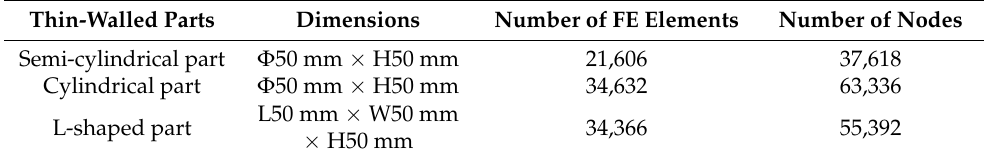
Figure 9. 3D FE mesh models of thin-walled structures. Table 3. Dimensions of the proposed thin-walled structures and the numbers of FE elements and nodes.